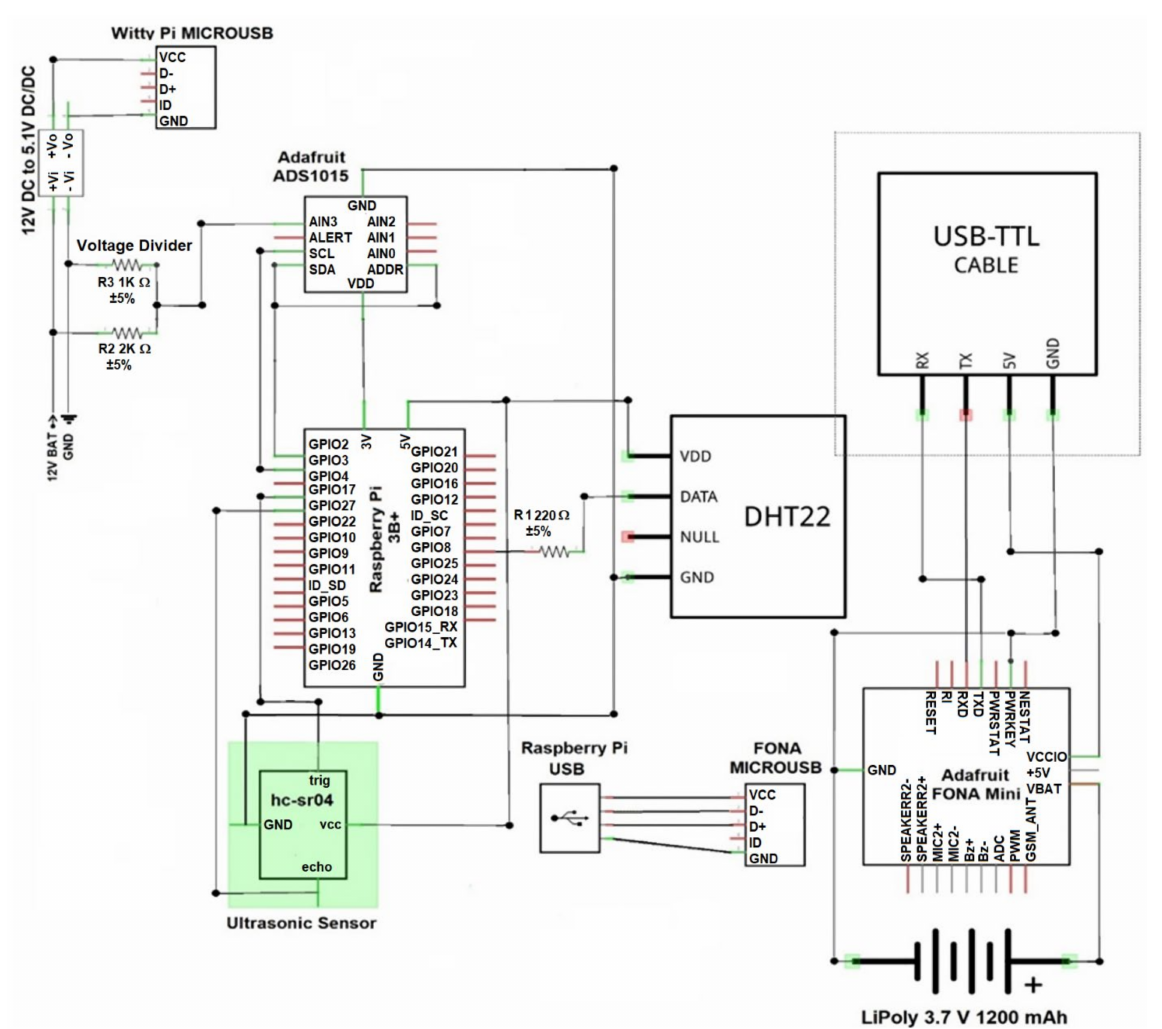
Figure 2. Schematic diagram of the hydrological monitoring